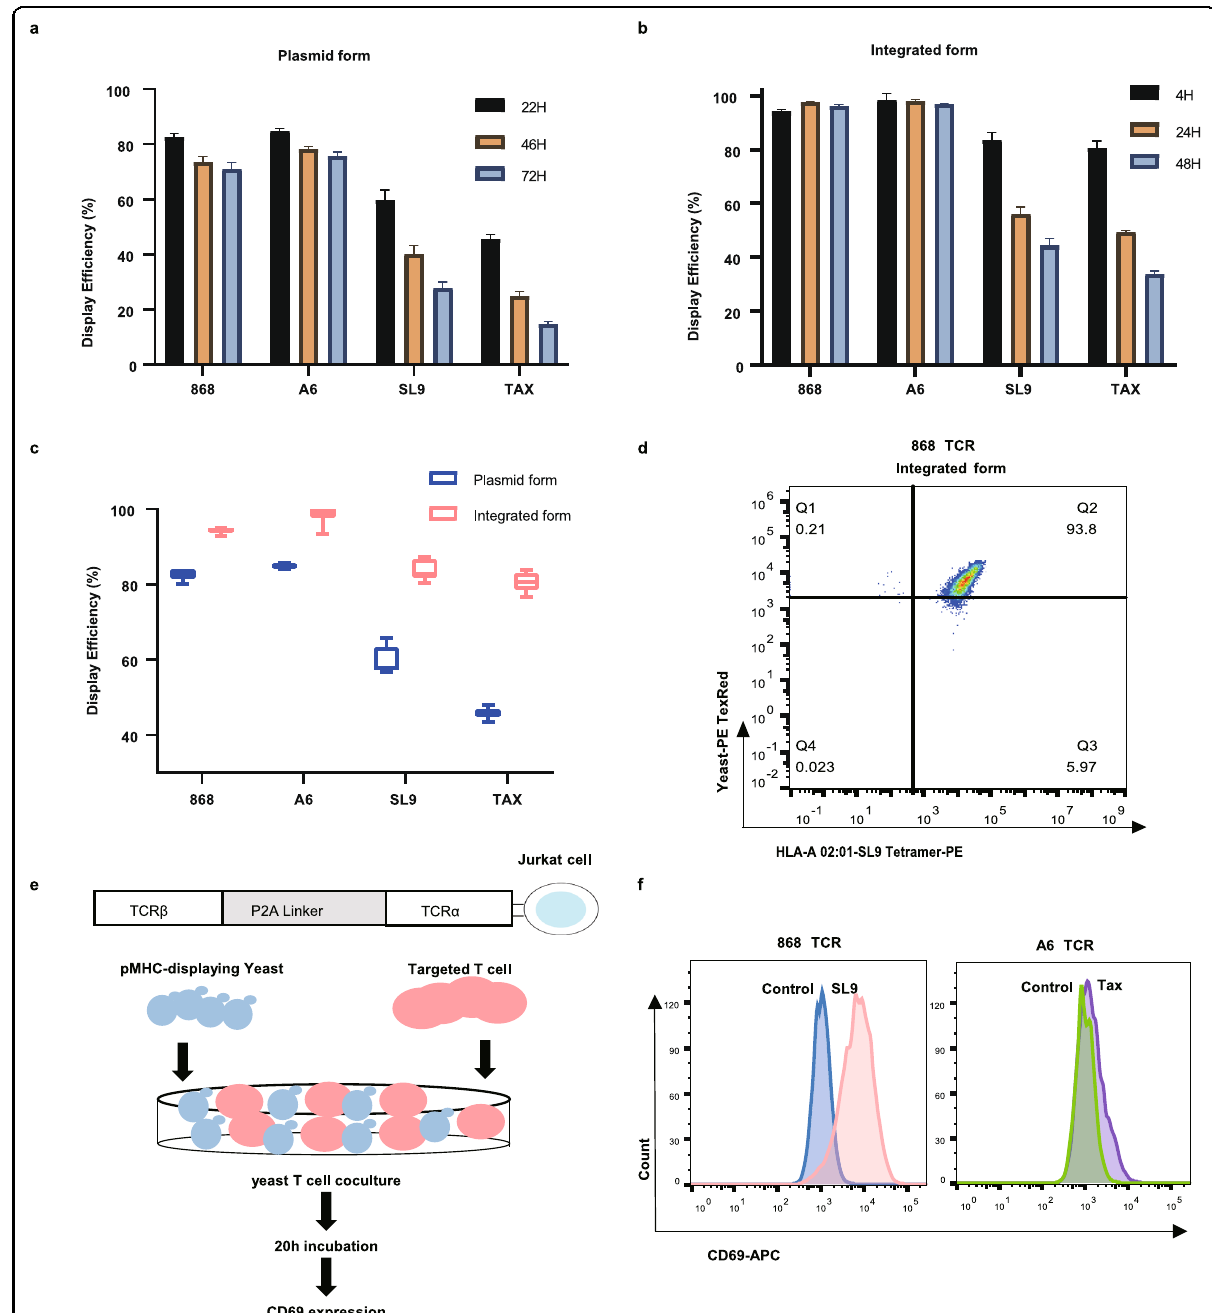
Fig. 2 Constitutively expressed TCR and pMHC achieved near 100% display ef fi ciency. a , b The display ef fi ciencies (mean ± sd) of TCRs (868 or A6) and pMHCs (SL9-HLA-A*02:01 or TAX-HLA-A*02:01) expressed in plasmid form ( a ) or integrated form ( b ). The display ef fi ciency was measured by FACS after staining the cells with HA-FTIC antibody at the indicated hours. Each experiment was performed with 2 technical repeats and was independently duplicated 3 times. The mean of the 6 duplicates is shown. c Comparison of the highest display ef fi ciencies achieved among the different time points for the plasmid and the integrated forms. d The 868 TCR expressed in the integrated form recognized the SL9-HLA-A*02:01 tetramer. The SL9- HLA-A*02:01 tetramer was labeled with PE, and mCherry in MATa yeast was detected using PE-TexRed. e A schematic diagram of the yeast T cell co-culture system. The cognate T cells were constructed by stable integration of a TCR β and a TCR α gene, which were linked by the P2A linker. The pMHC-displaying yeast was the same as shown in Fig. 1a. pMHC-displaying yeasts were cocultured with cognate T cells for 20 h, followed by FACS to detect CD69 expression in T cells using an APC-conjugated CD69 antibody. f The 868 T cells and A6 T cells can be activated by cognate pMHC-displaying yeasts. Histograms showed staining by the APC-conjugated CD69 antibody. Representative data from one out of three biological replicates are